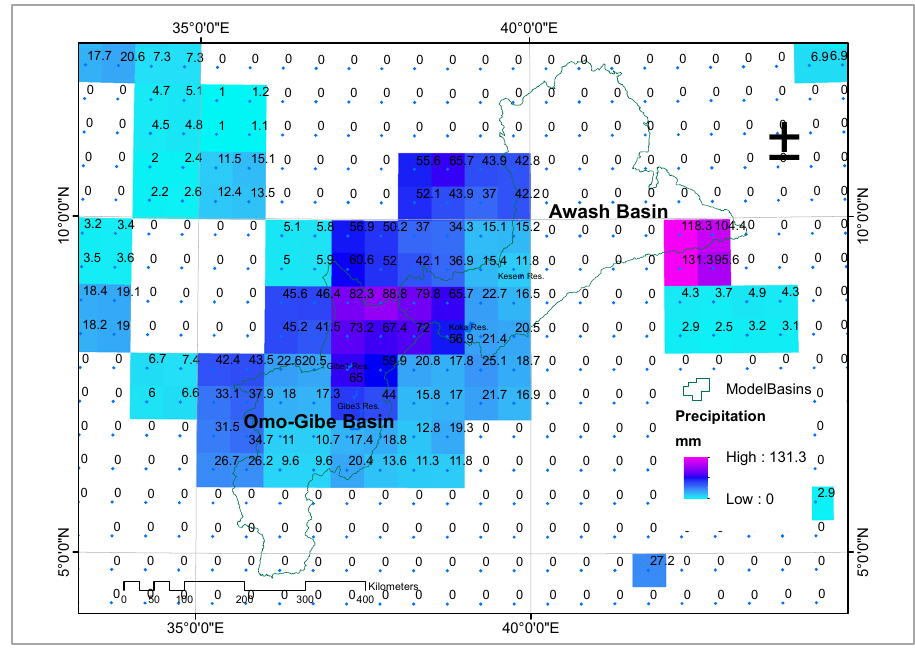
Figure 2. Gridded precipitation over the model basins.